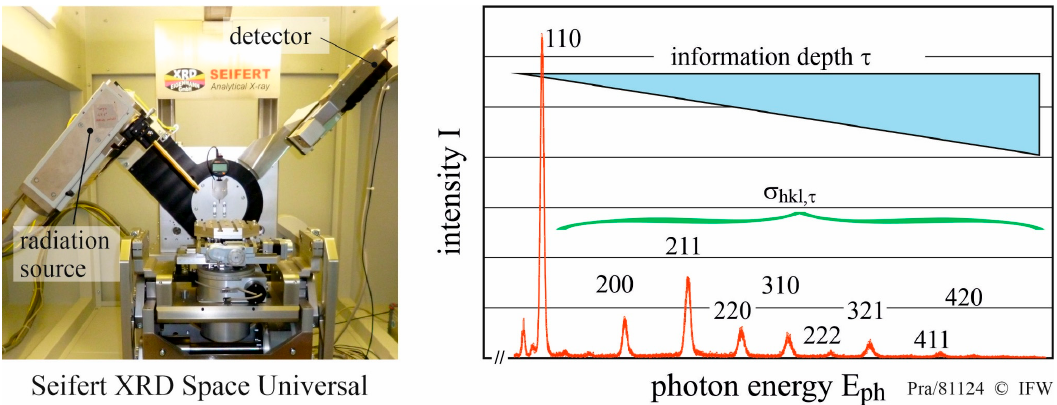
Figure 2. Energy ‐ dispersive residual ‐ stress measurement. Figure 2. Energy-dispersive residual-stress